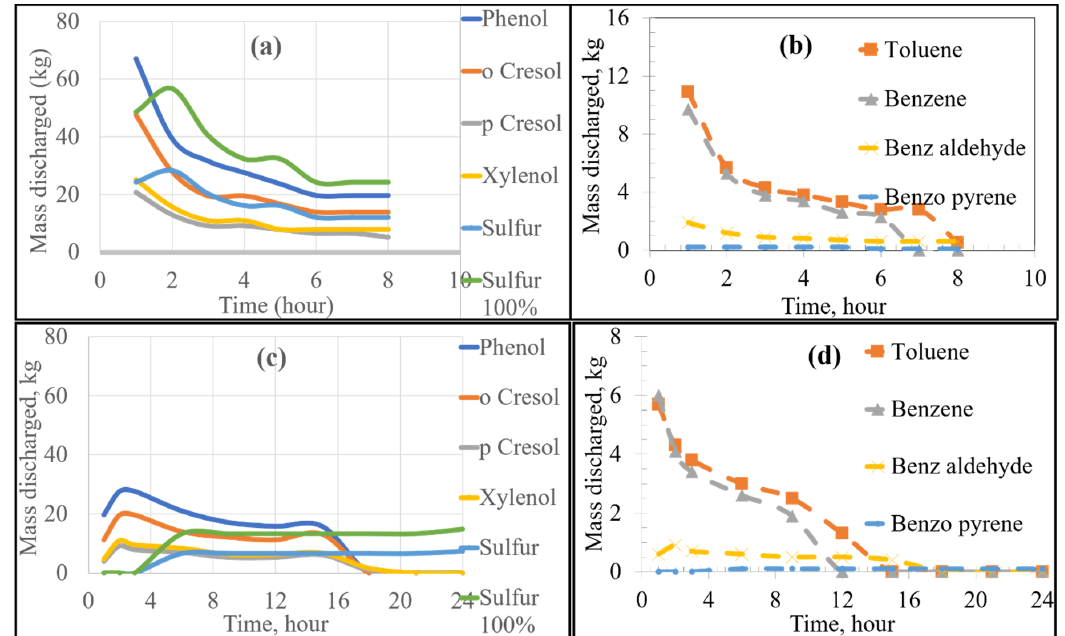
Figure 4. Emissions at the brick as a function of heating time: Low Sulfur Emission Case; ( a ) and ( b ) show the Current Operation, and ( c ) and ( d ) show the Future Operation.